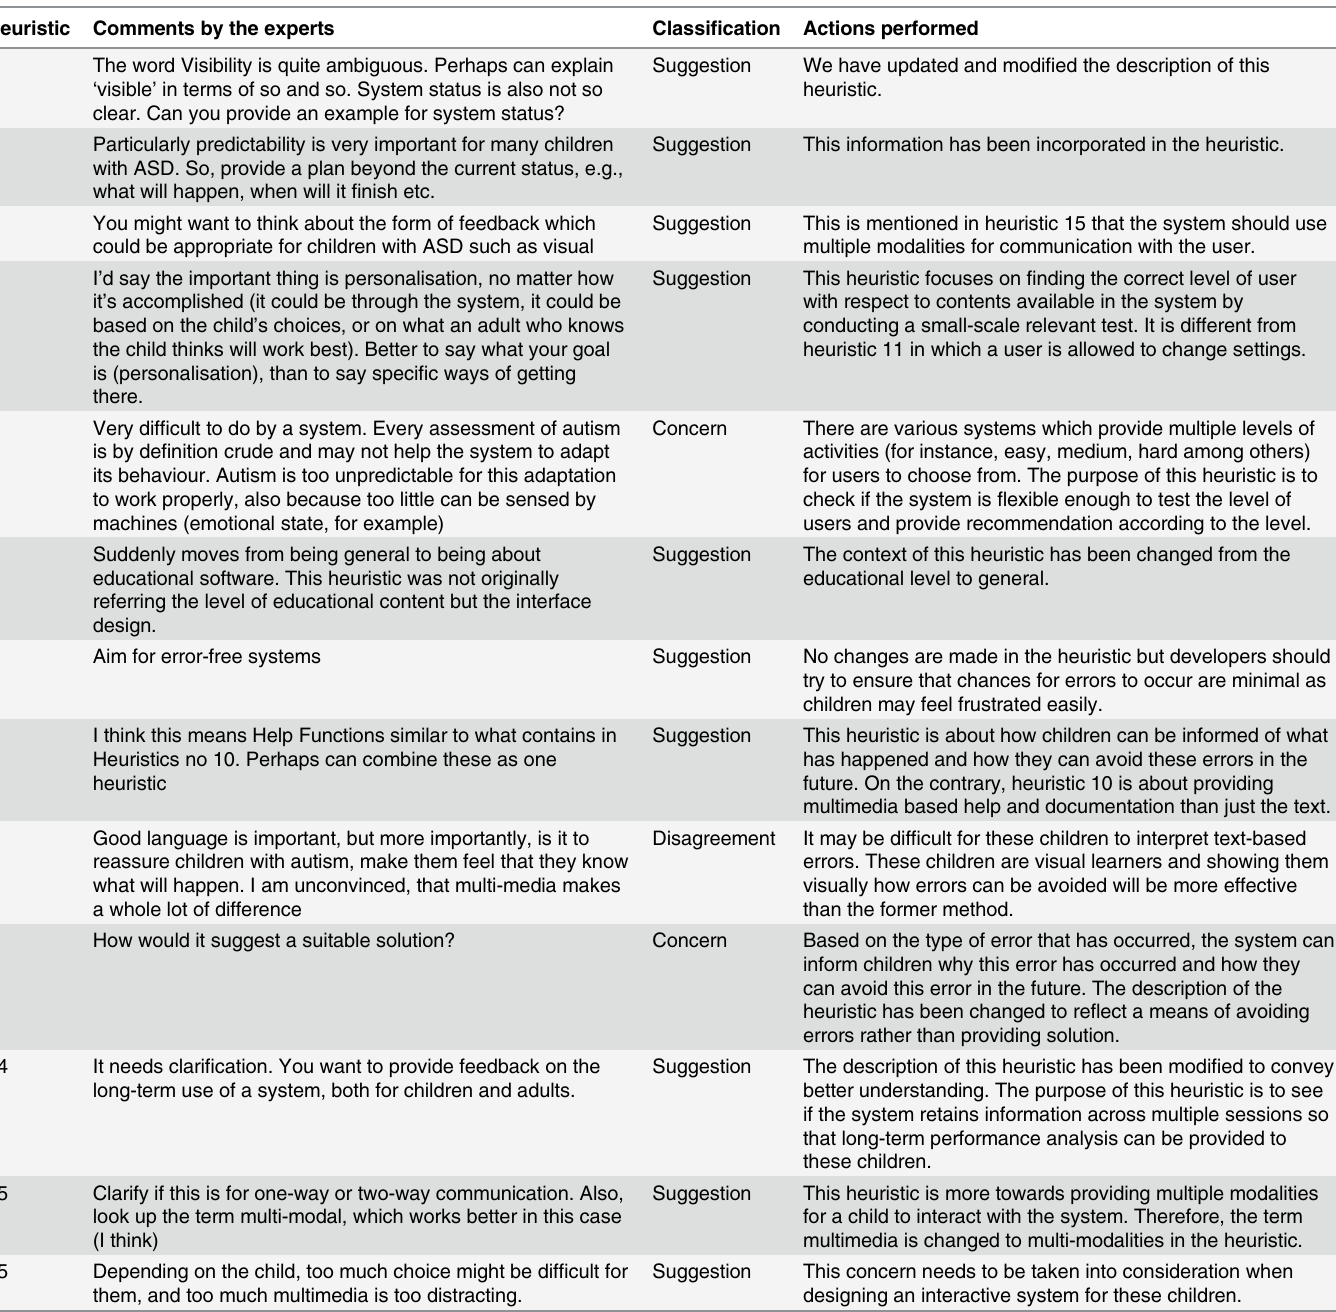
Table 6. Comments of experts and the actions